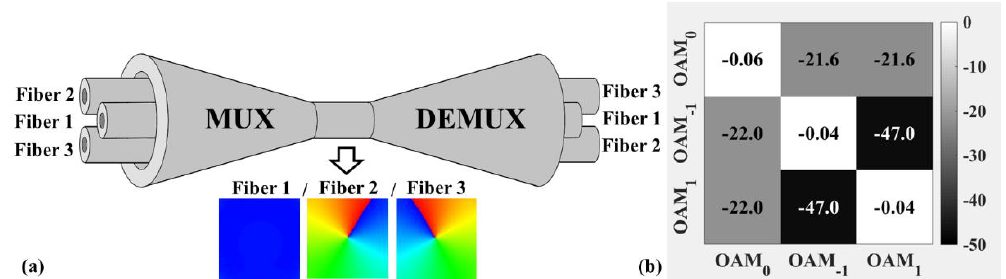
Figure 5. ( a ) The schematic of the multiplexer/de-multiplexer (MUX/DEMUX) simulation. ( b ) Calculated mode crosstalk matrix of one pair of the OAM-MSPLs during selective excitation (bottom axis) and measurement (left axis). The diagonal matrix elements represent the simulated insertion loss of one pair of the OAM-MSPLs. OAM-MSPLs: orbital angular momentum mode-selective photonic lanterns.